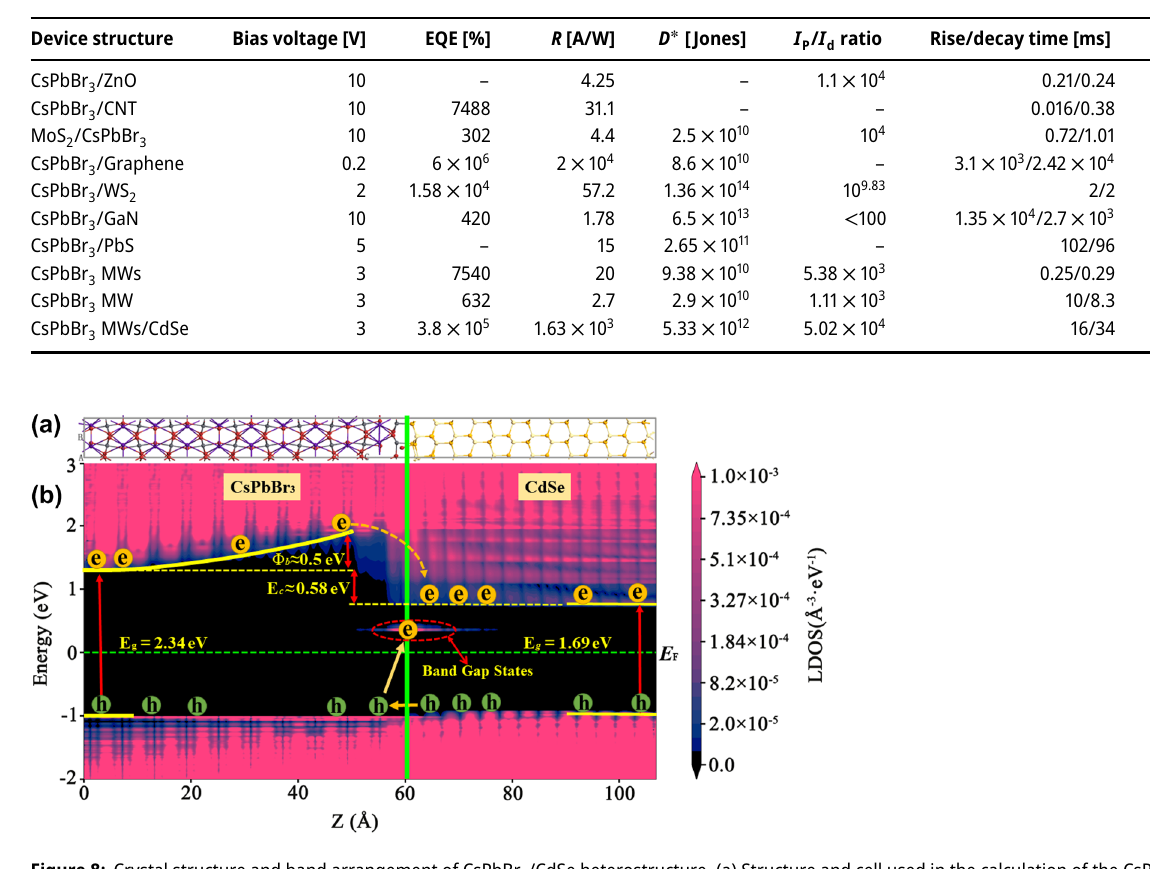
/CdSe heterostructure. (a) Structure and cell used in the calculation of the CsPbBr 3 /CdSe 3